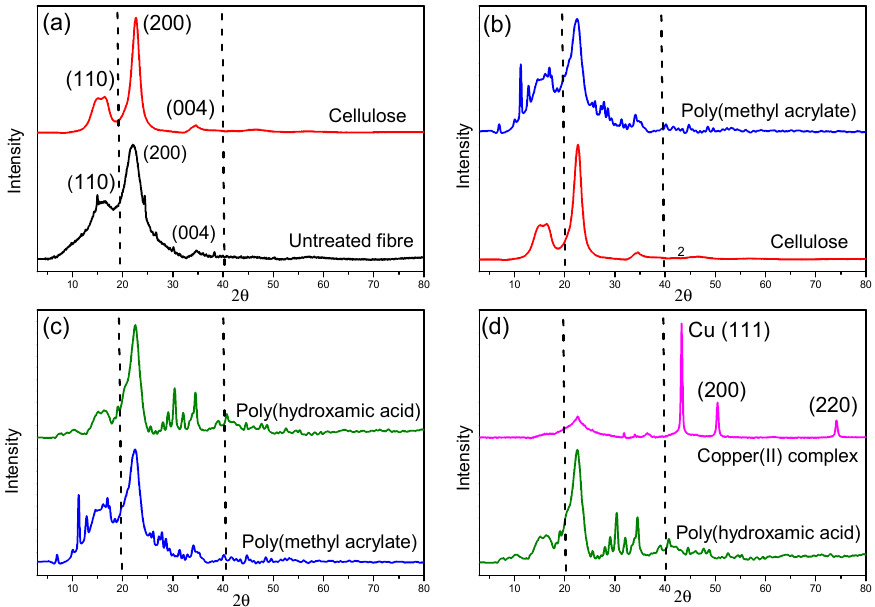
Figure 5. X-ray diffraction (XRD) patterns of ( a ) cellulose, ( b ) PMA-grafted cellulose, ( c ) PHA ligand and ( d ) PHA–Cu. complex.